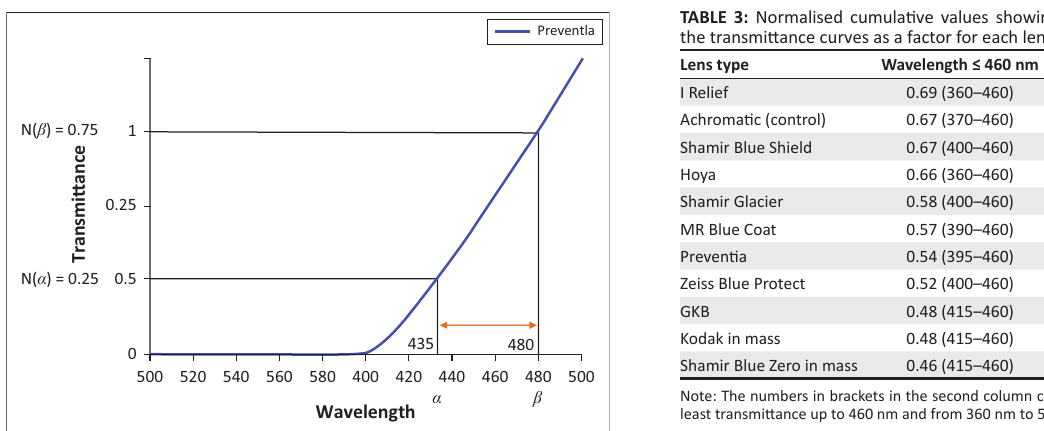
FIGURE 5: Consider wavelengths α and β such that N( α ) = 0.25 and N( β ) = 0.75. Then this means that 50 % of the total integrated transmission through a lens occurs on the band from α to β .